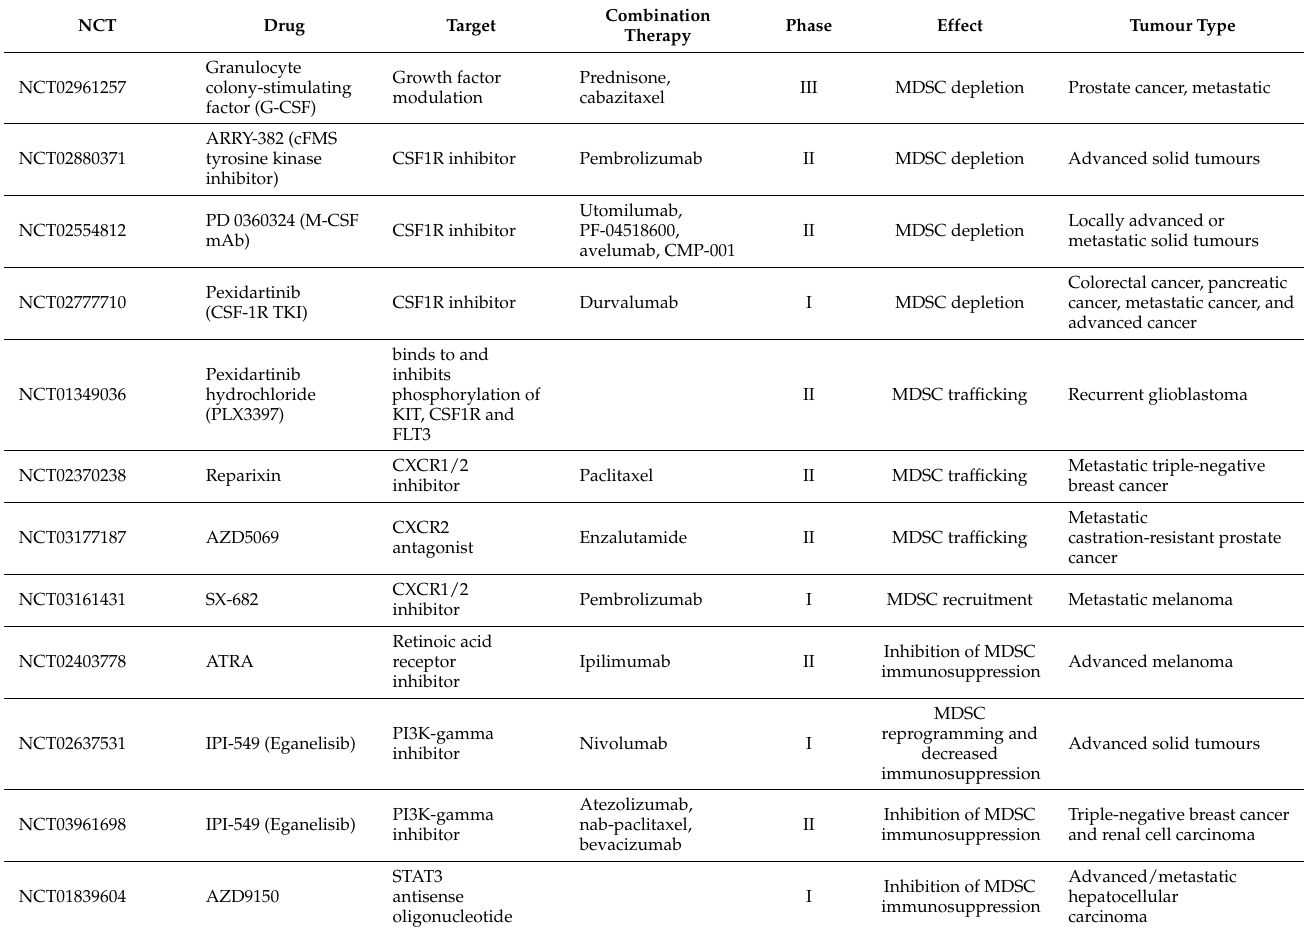
Table 2. Current MDSC targeting clinical